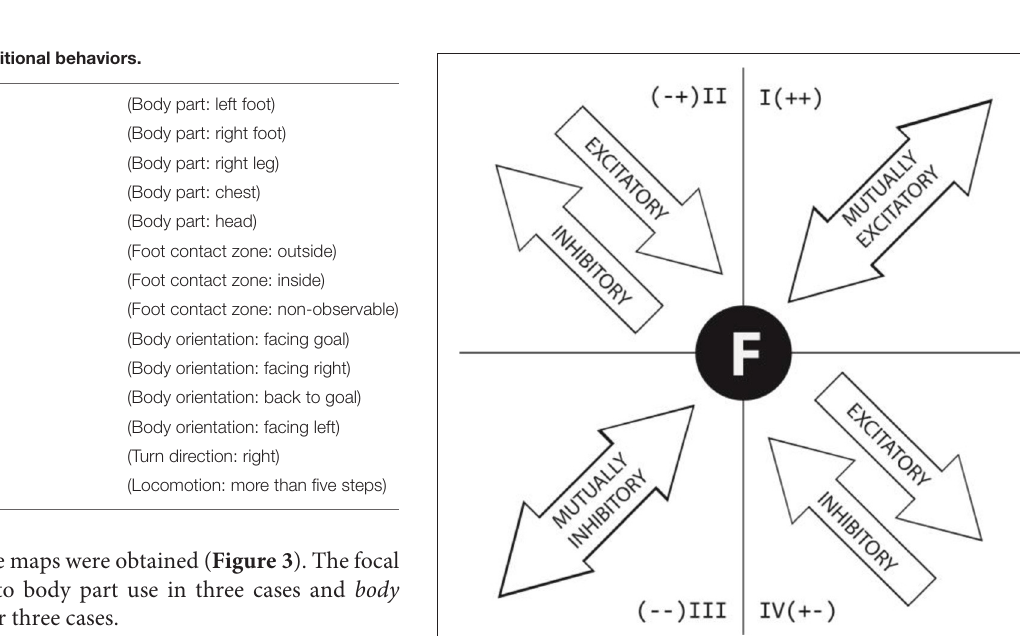
FIGURE 1 | (A) Body orientation angles, with the center circle representing the player’s body. FG indicates facing goal; BT, back to goal; OL, facing left side line; OR, facing right side line. (B) Division of pitch into zones. LW, indicates left wing; CL, left midfield; CR, right midfield; RW, right wing: UOO, ultraoffensive zone 1; UOT, ultraoffensive zone 2; OFF, offensive zone; CEN, central zone.